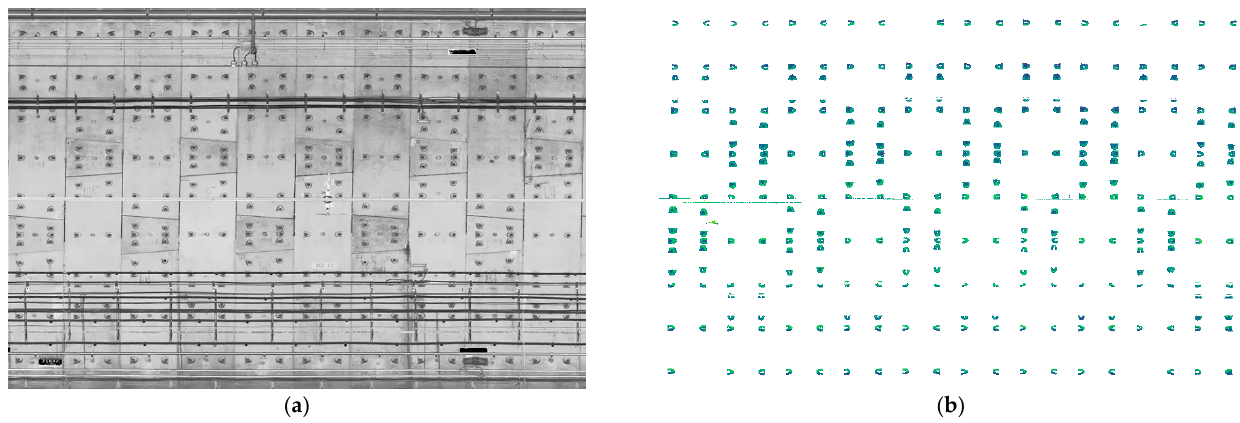
Figure 5. Effect drawing of extracted bolt holes. ( a ) Tunnel lining gray image and ( b ) extraction of bolt hole point cloud.